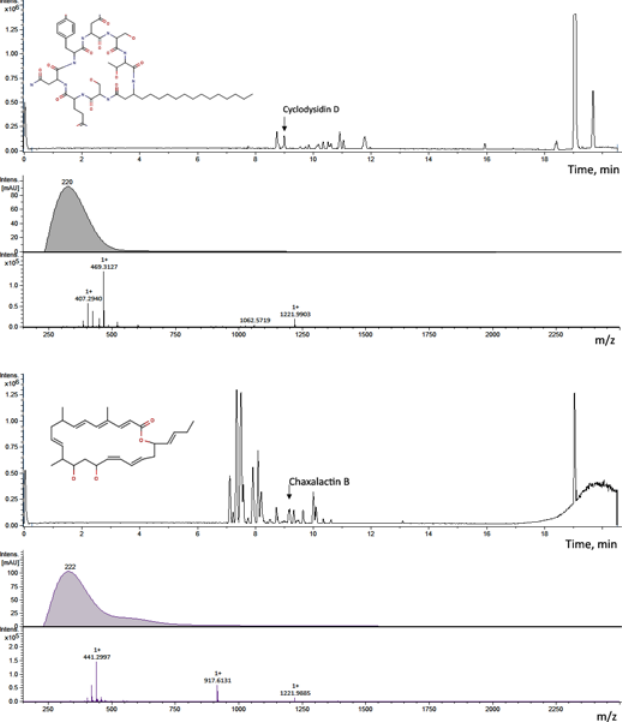
Fig 2. Structure of Cyclodysidin D and Chaxalactin B and their identification in extract of Streptomyces sp . IB 2014/I/78-8 .